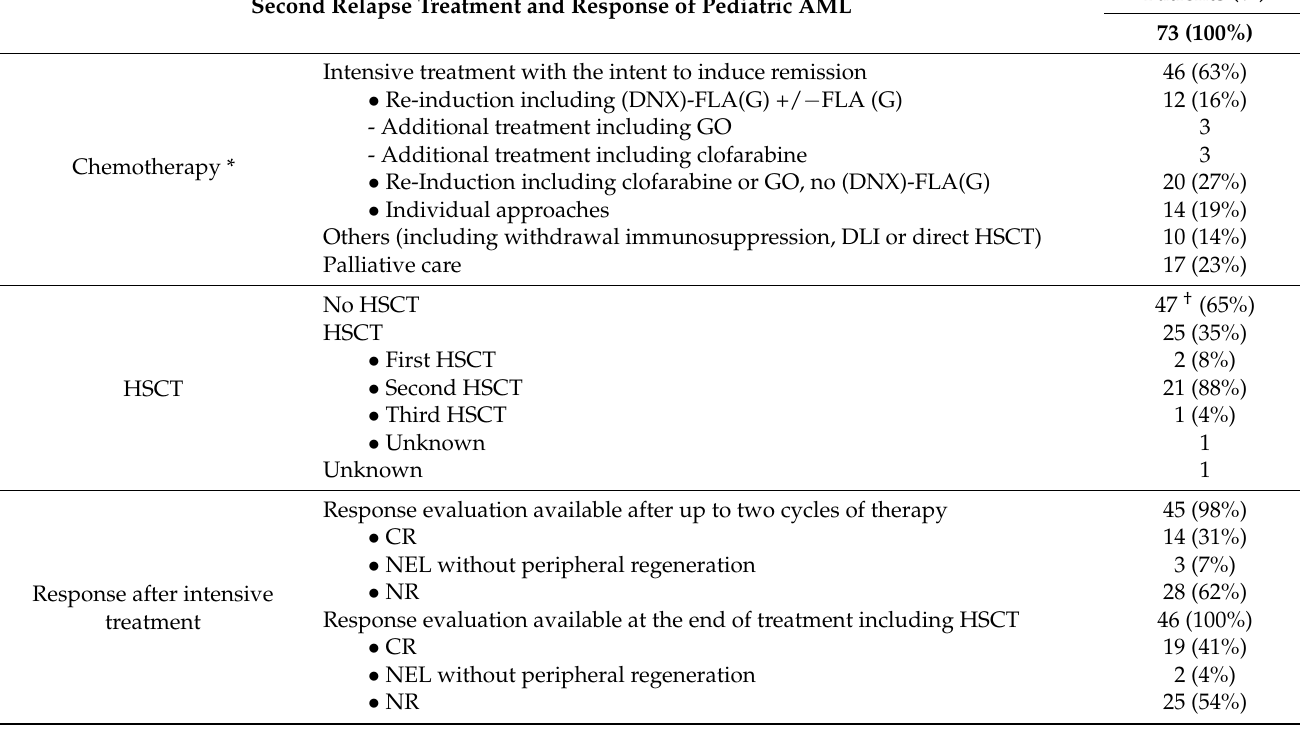
Table 2. Treatment and